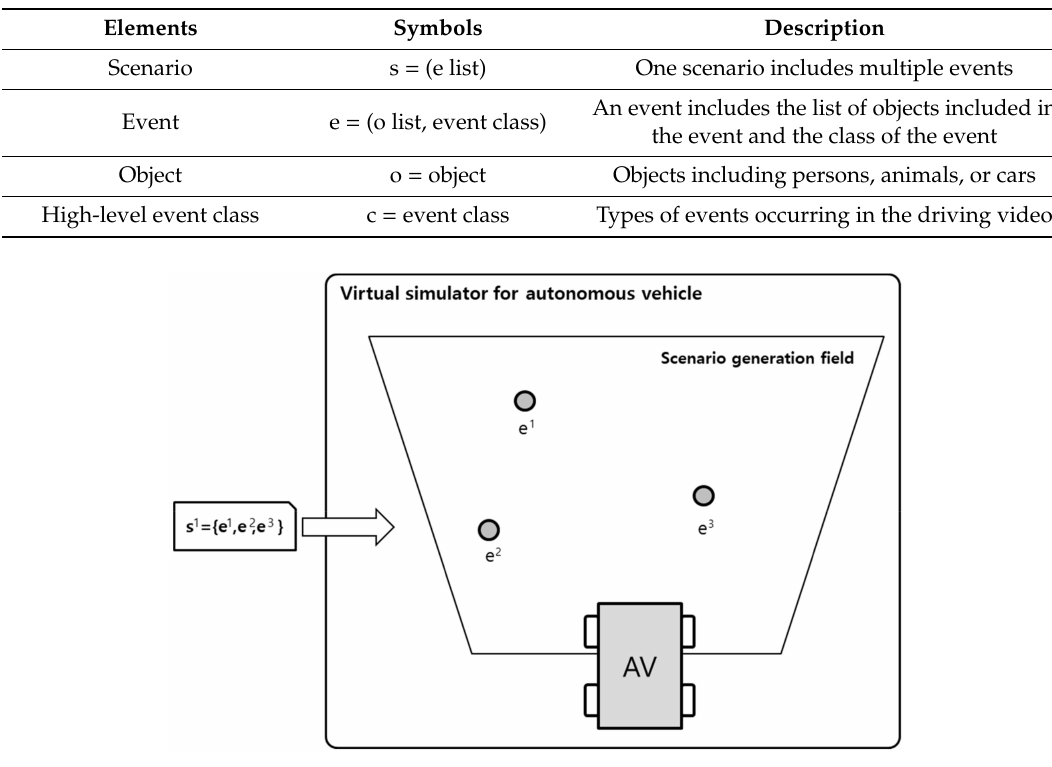
Figure 4. Long-term recurrent convolution networks (LRCN)-based event classification model structure. Table 1. List of scenario elements.